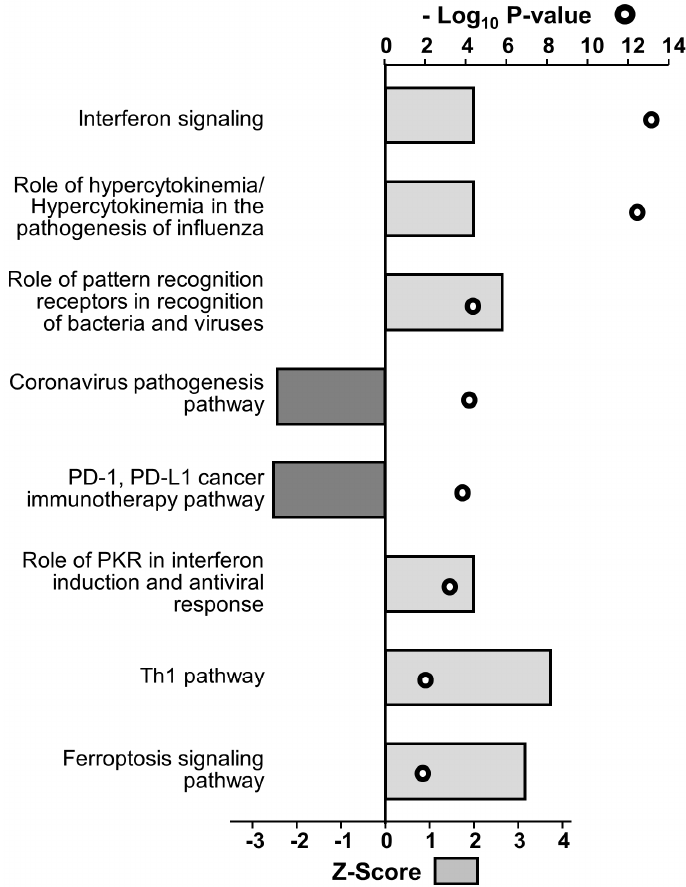
Figure 4. ZIKV—induced top dysregulated canonical pathways based on the expression profile of U251 cells at 48 hpi, as generated by IPA software. Light grey bars are predicted activation and dark grey bars are predicted inhibition based on the list of significantly dysregulated proteins at 48 h post ZIKV infection in U251 cells found by mass spectrometry. 2 tailed Students T—test was used to determine statistical significance (top axis), and degree of predicted activation/inhibition was determined by Z-score (bottom axis). For each of them, the cut off p -value is 0.05 and the cut off Z-score value is +/ − 1.96 σ .